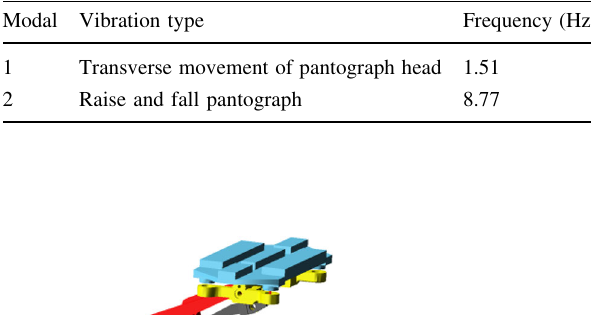
Table 2 The modal characteristics of the pantograph rigid body model Modal Vibration type